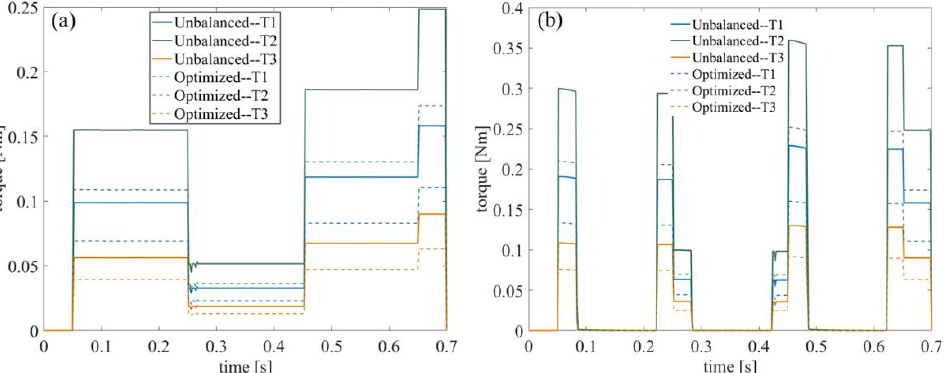
Figure 9. The shaking moment of the unbalanced and optimized SPR at ( a ) “low” and ( b ) “high” for trajectory 1.